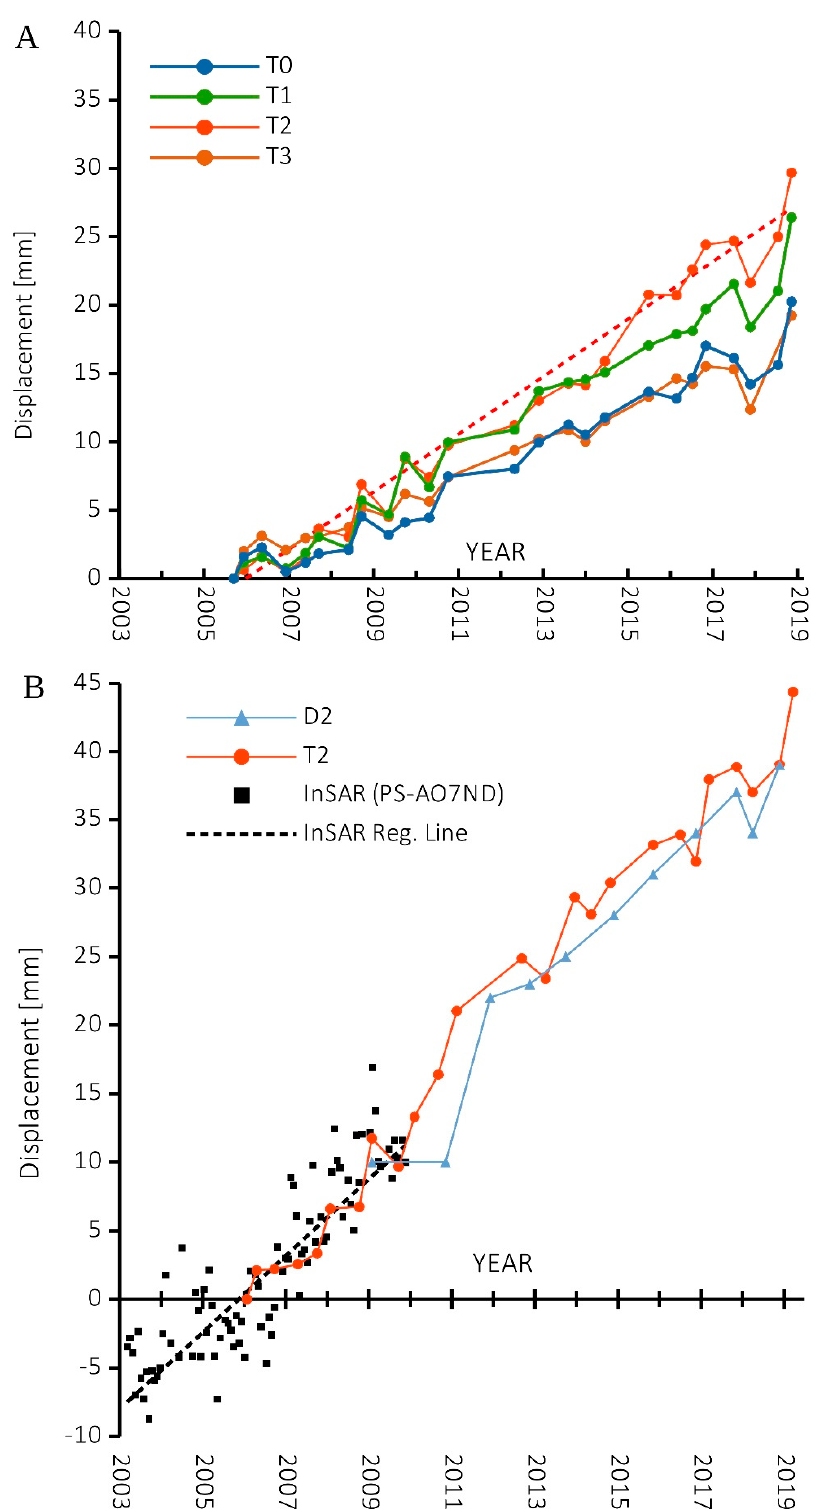
Figure 10. ( A ) shows the Time Series of 2D (horizontal) displacement of the topographic benchmarks (T0, T1, T2, T3) and the linear regression represented as red dashed line for T2 (the equation is f(x) = 0.006x − 224.3; R 2 = 0.97; ( B ) shows the 3D time-series displacement of: benchmark T2; the laser distance meters D2; the PS InSAR data (PS id: AO7ND Radarsat ascending dataset) with its linear regression represented by the black dashed line (the equation is f (x) = 0.008x − 295.3; R 2 = 0.77).